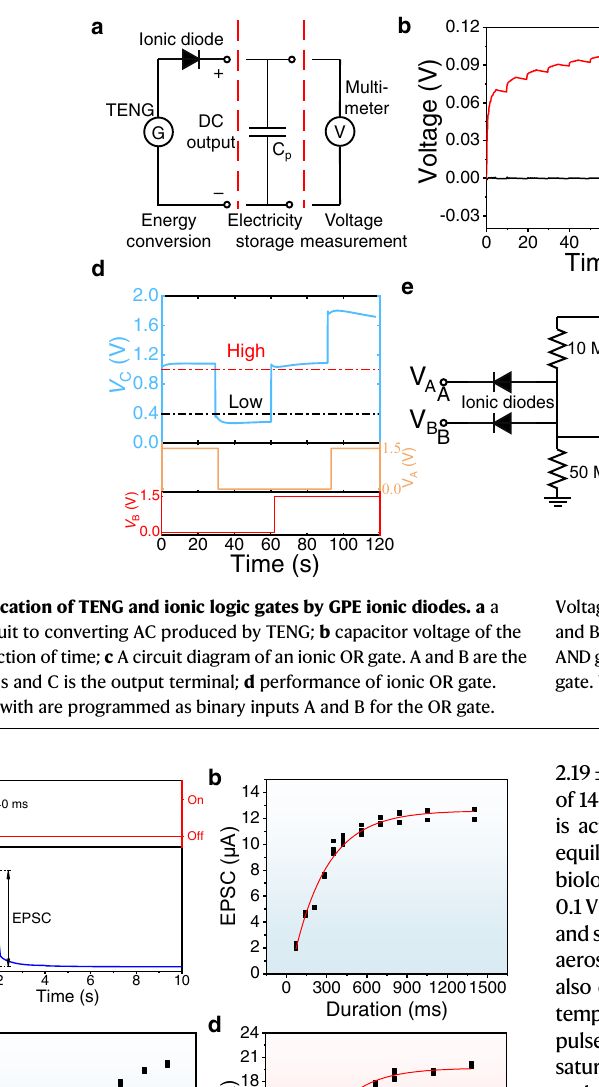
Fig. 6 | EPSC of GPE ionic diodes. a EPSC induced by a − 1V presynaptic voltage withthedurationof140ms; b EPSCasafunctionofspikedurationinducedbythe − 1Vpresynapticvoltage; c EPSCasafunctionofpresynapticvoltagewithspikewidth maintained at 140ms; d EPSC as a function of spike duration induced by the − 1V presynaptic voltage under high temperature of